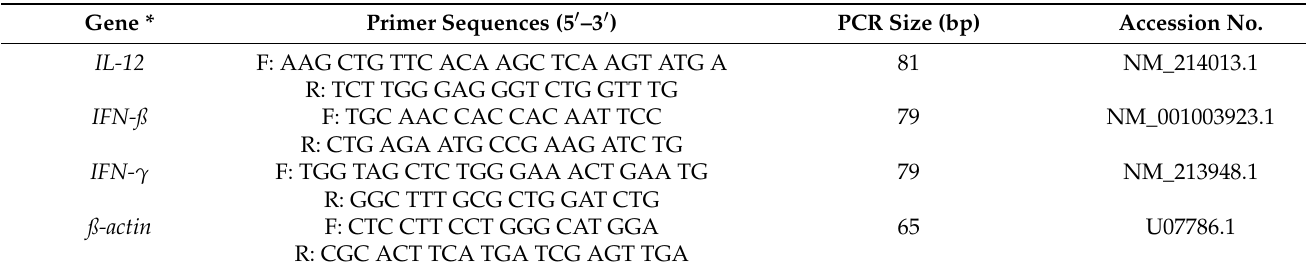
Table 2. Primer sequences for the semi-quantitative real-time PCR